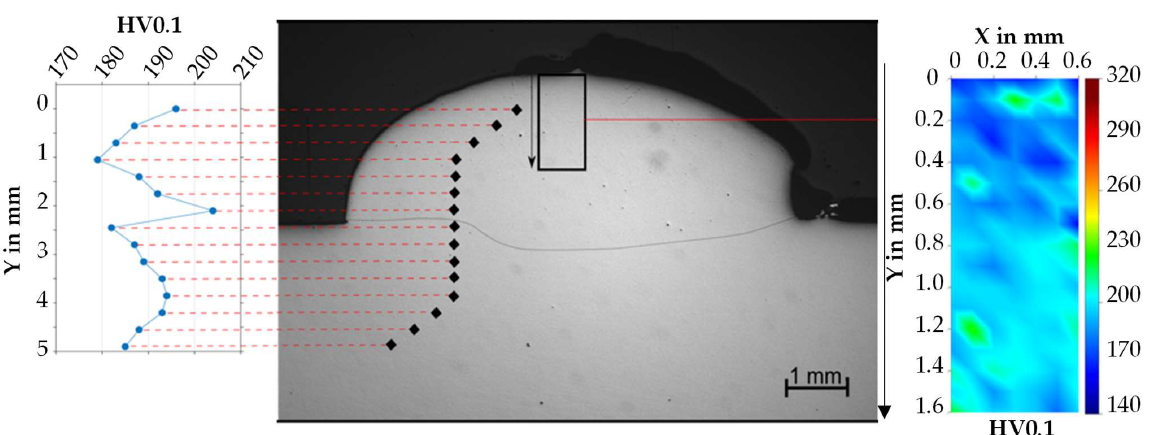
Figure 10. Cross-section and result of the hardness measurement of the sample tandem P1 (P1, I1 = 180 A, I2 = 90